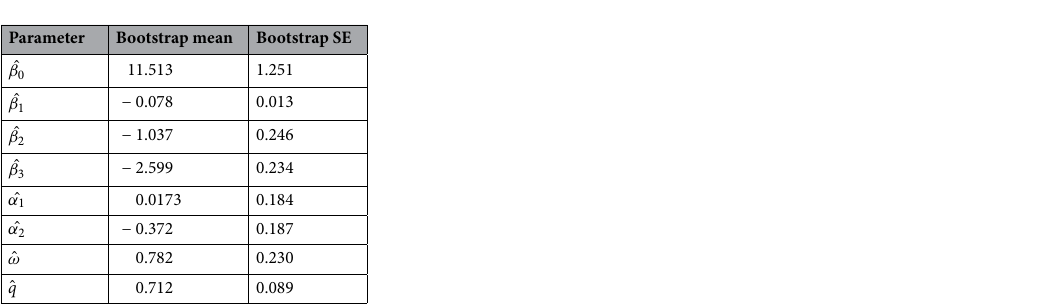
Table 4. Bootstrap means and standard errors of the proposed model for the Catalonia Covid-19 example.